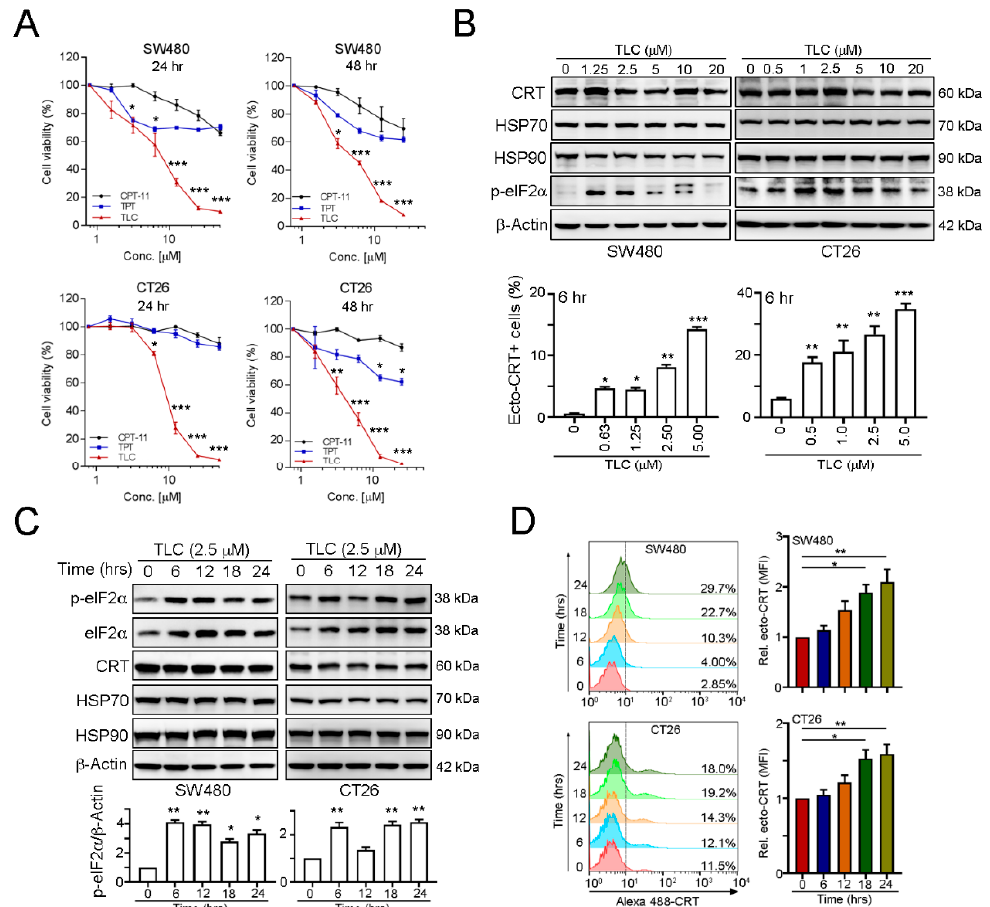
Figure 1. Lipotecan (TLC) triggered a decrease in cell viability and promoted endoplasmic reticulum (ER) stress. ( A ) SW480 and CT26 cells were treated with diverse concentrations of TLC for 24 and 48 h. Cell viability was examined by CCK-8 assay ( n = 3). * p < 0.05, ** p < 0.01 and *** p < 0.001. ( B ) SW480 and CT26 cells were treated with diverse concentrations of TLC for 24 h and examined by immunoblotting. The level of surface CRT was analyzed by flow cytometry. Quantification of these results is shown ( n = 3). * p < 0.05, ** p < 0.01 and *** p < 0.001. ( C ) SW480 and CT26 cells were treated with TLC for different time periods and examined by immunoblotting. Quantification of these results is shown ( n = 3). * p < 0.05 and ** p < 0.01. ( D ) SW480 and CT26 cells were treated with TLC for different time periods and examined by flow cytometry. Quantification of these results is shown (means ± S.D.s., n = 3). * p < 0.05 and ** p < 0.01. More details of western blot, please view at Figures S1 and S2.